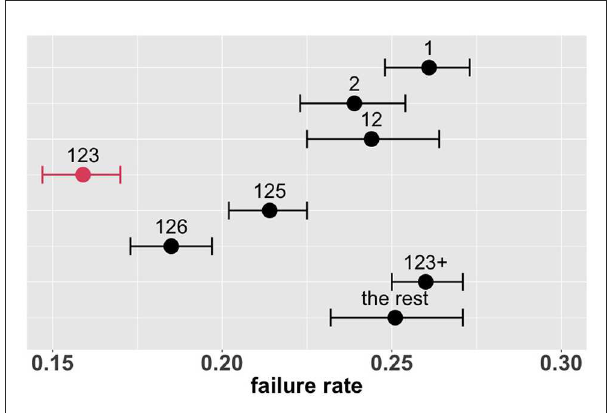
adjustment for multiplicity) (1: lopinavir-ritonavir-arbidol, 2: interferon, 3: methylprednisolone, 4: tocilizumab, 5: oseltamivir, 6: ribavirin, 7: favipiravir, 8: